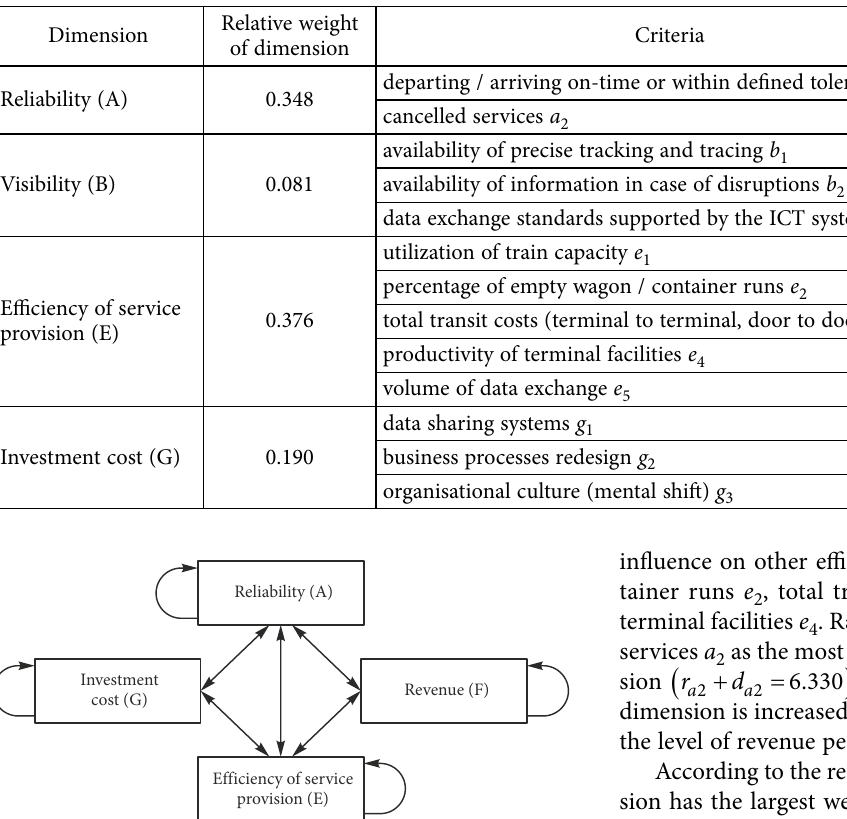
Table 7. Influential weights of DEMATEL–ANP for each criterion obtained by